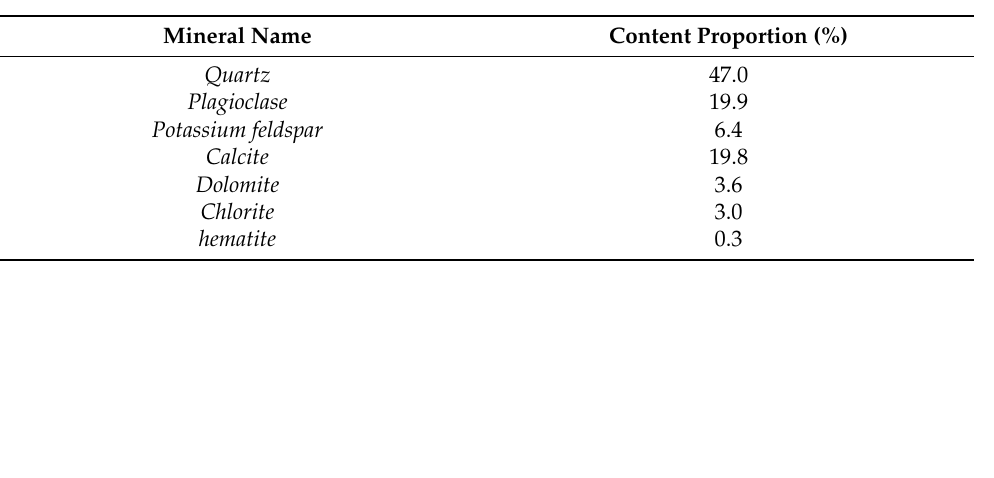
Table 1. Mineral composition in Samples A1 and